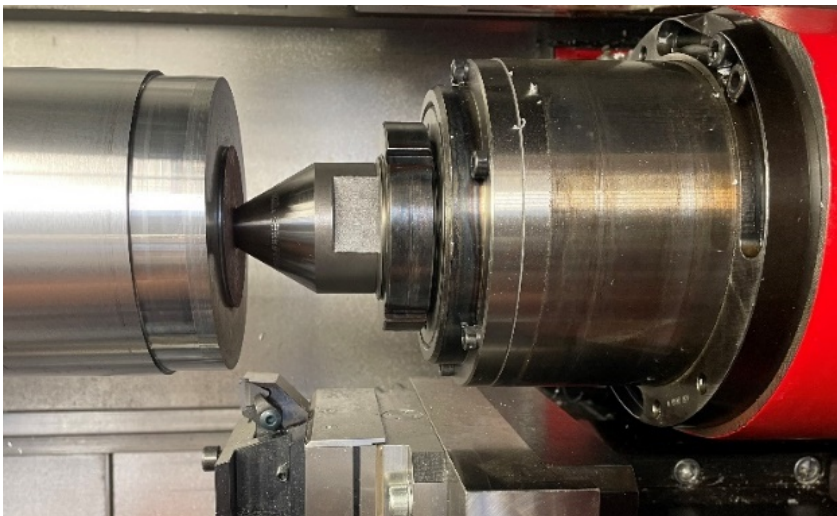
Figure 3. Experimental setup of the SP 430 SY 2 1100 CNC turning machine.